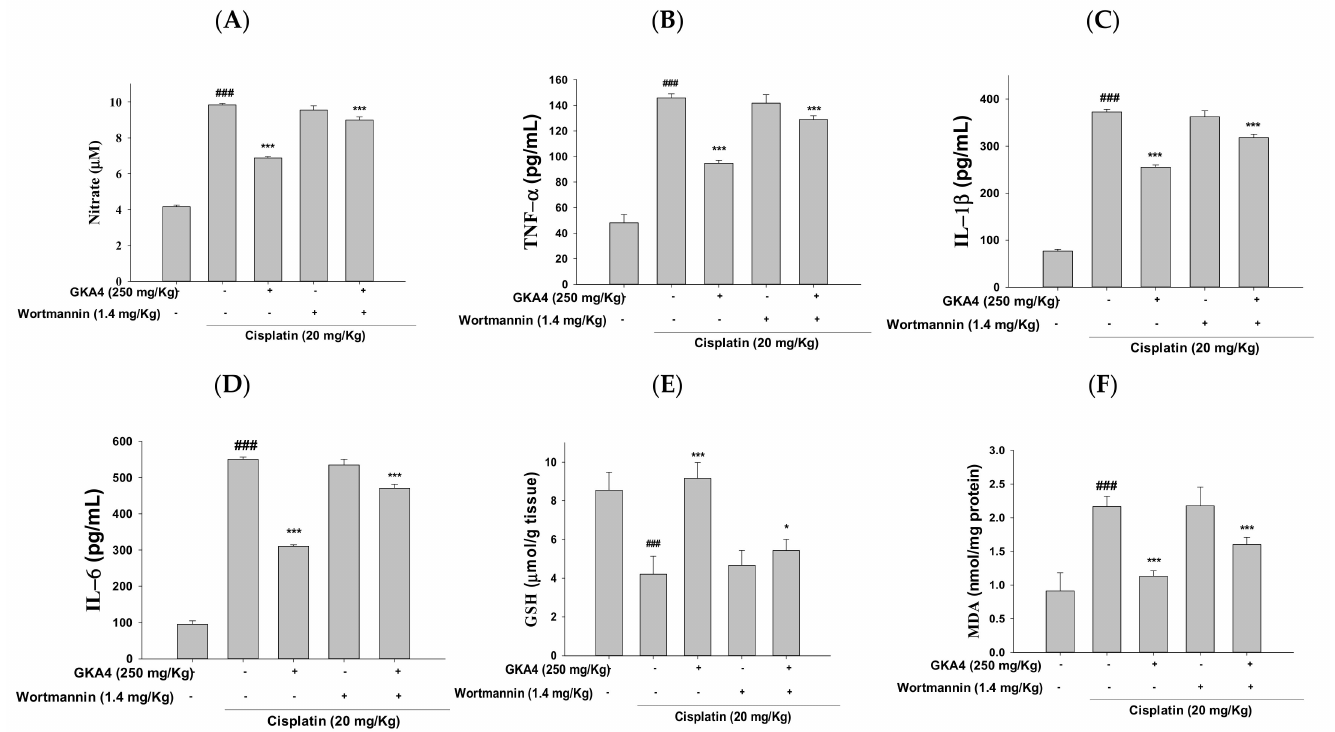
Figure 9. GKA4 and wortmannin changed the NO ( A ), TNF- α ( B ), IL-1 β ( C ), IL-6 ( D ), GSH ( E ), and MDA ( F ) levels after cisplatin-treated AKI. The Griess reaction assay determined the nitrite concentration. ELISA kits were used to evaluate the levels of pro-inflammatory cytokines. The values were displayed as means ± S.E.M ( n = 5). ### denotes p < 0.001 compared with the sample of the control group. * p < 0.05 and *** p < 0.001 compared with the cisplatin